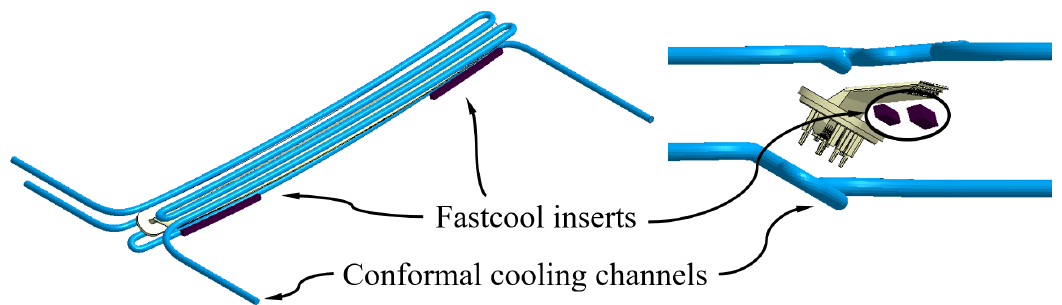
Figure 9. Hybrid cooling system design, dashed Fastcool bars. Table 7. Geometric variables of the traditional cooling system design.